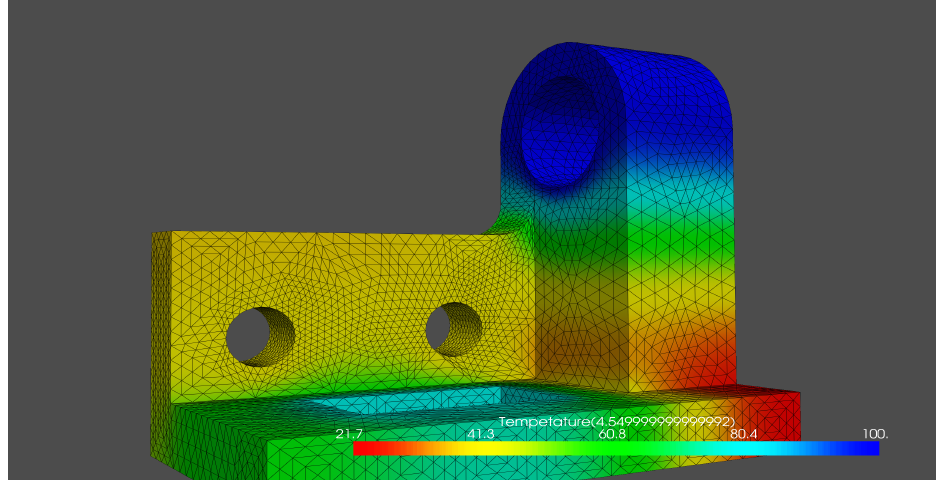
Figure 12. Temperature contour of a function space of order 1 at t = 4.55 s.